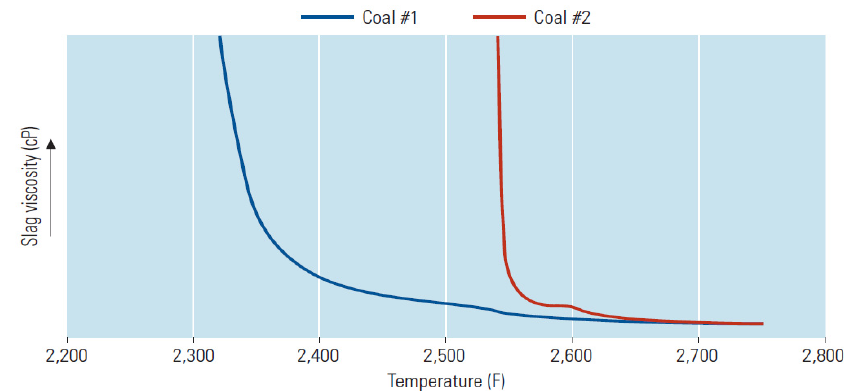
Figure 3. Slag viscosity versus temperature for two different coals with the same ash fusion temperatures